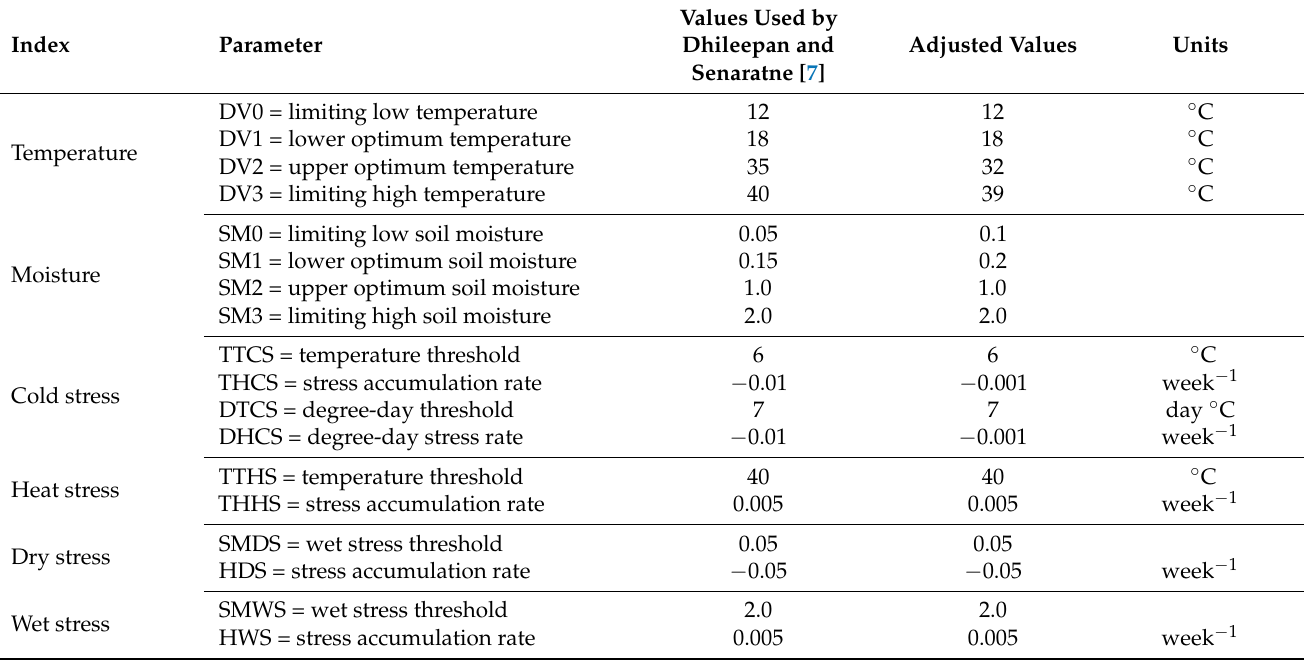
Table 2. CLIMEX parameter values used in this present study and those of Dhileepan and Senaratne [7] for modeling the potential distribution of the biological control agent Zygogramma bicolorata